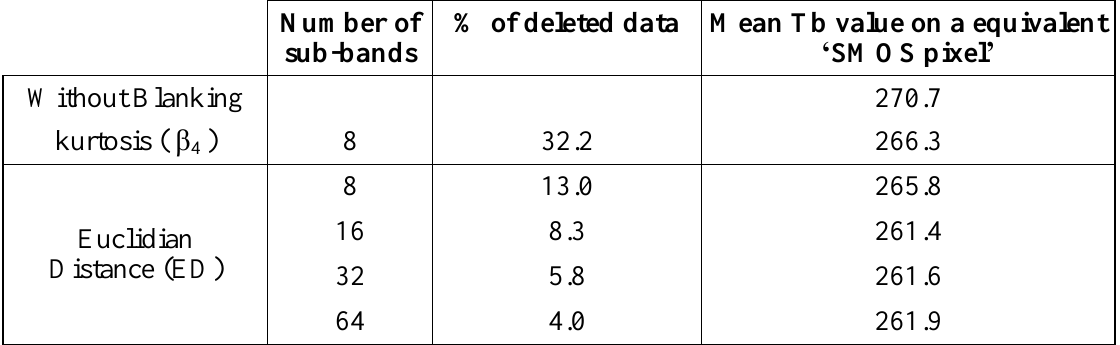
Table 4. % of deleted data and mean Tb values, for two different masking algorithms, and division of the spectrum into 8, 16, 32 and 64